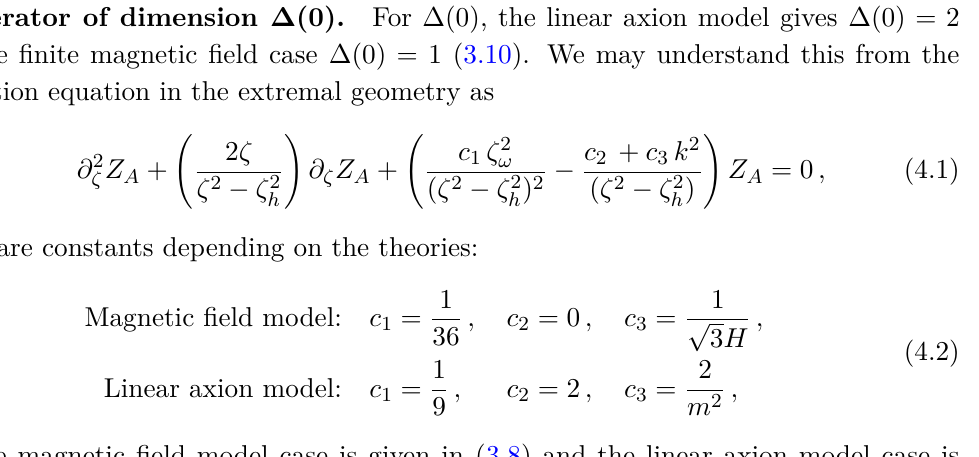
Figure 7 . Quasi-normal modes (black dots) at H/T 2 = (10 5 , 3 × 10 7 ) (left, right). The solid line is the hydrodynamic mode (2.9) and the dashed line is the first non-hydrodynamic mode ω Note that the left figure is the gray square region in figure 2(a). As T is lowered from (a) to (b), the quasi-normal modes (black dots) are getting better and better approximated with i) the hydrodynamic mode (solid line); ii) the non-hydrodynamic mode (dashed